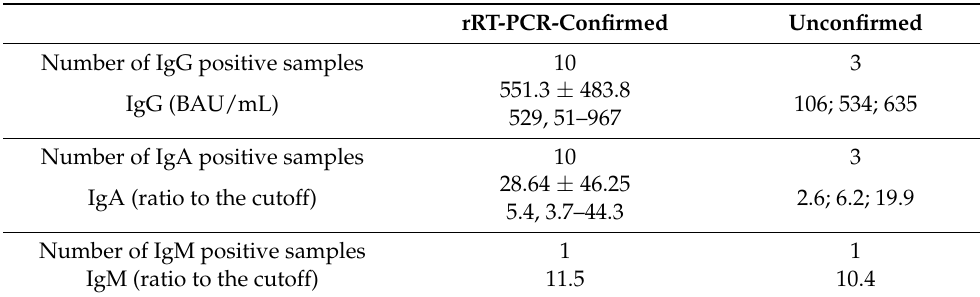
Table 3. Anti-SARS-CoV-2 antibody levels in relation to the history of rRT-PCR-confirmed ( n = 11) or unconfirmed ( n = 3) SARS-CoV-2 infection in hemodialysis